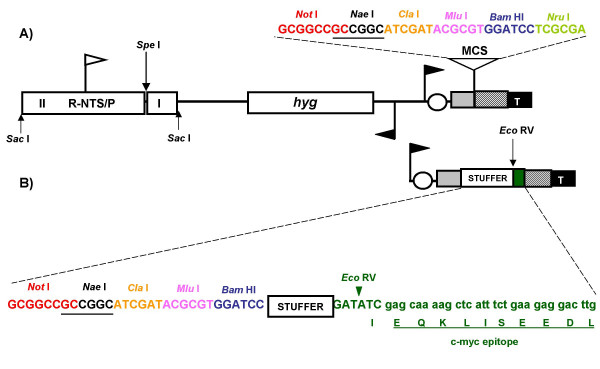
The T. cruzi inducible expression vectors pTcINDEX and pTcINDEX-C-myc. (A) Map of pTcINDEX. The grey box adjacent to the multiple cloning site (MCS) indicates the ribosomal protein P2β splice acceptor site [25]. The hatched box indicates the T. cruzi actin intergenic region. The black box (T) is the T7 transcriptional terminator. Black flags represent T7 promoters and the oval identifies the location of the tet operator. R-NTS/P is the ribosomal non-transcribed spacer and promoter region used to target the construct. Roman numerals I and II indicate the two halves of the targeting sequence which are cloned in the opposite order to their position in the genome (see Fig. 3A). The white flag indicates the location of the pol I transcription start site [24]. Following insertion of a gene of interest into the MCS, the construct can be linearised with Spe I (dotted line) to facilitate targeting to the rRNA non-transcribed spacer region. The vector is built on a pUC19 backbone (not illustrated for clarity) and confers ampicillin resistance on E. coli. The sequence of the MCS is shown above the map indicating useful restriction sites. Nae I and Nru I were incorporated as blunt end sites to facilitate cloning of genes which contain the other restriction sites. (B) Map of pTcINDEX-C-myc. The inducible cassette alone is shown for clarity. The rest of the vector is identical to pTcINDEX. Features are as shown in A, except that the BPP1-myc fusion gene has been inserted into the Bam HI/Nru I sites of pTcINDEX (Methods). The white box labelled "stuffer" indicates the dispensable BPP1 ORF [48]. This can be removed by digestion with one of the MCS enzymes and Eco RV and replaced with the gene of interest. The c-myc epitope tag is indicated by a green box. The Eco RV cleavage site and the translated sequence of the c-myc tag (underlined) are indicated to allow easy design of in-frame fusions with the epitope tag. Note the Nru I site is absent in this plasmid.